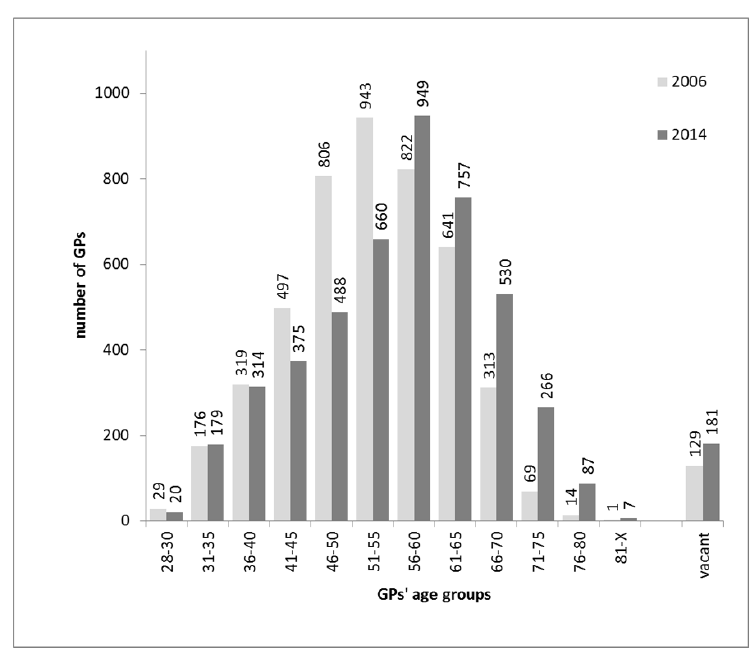
Figure 1. Changes in the age distribution of Hungarian general practitioners responsible for the provision of primary health care to adults and number of vacant practices between 2006 and 2014.